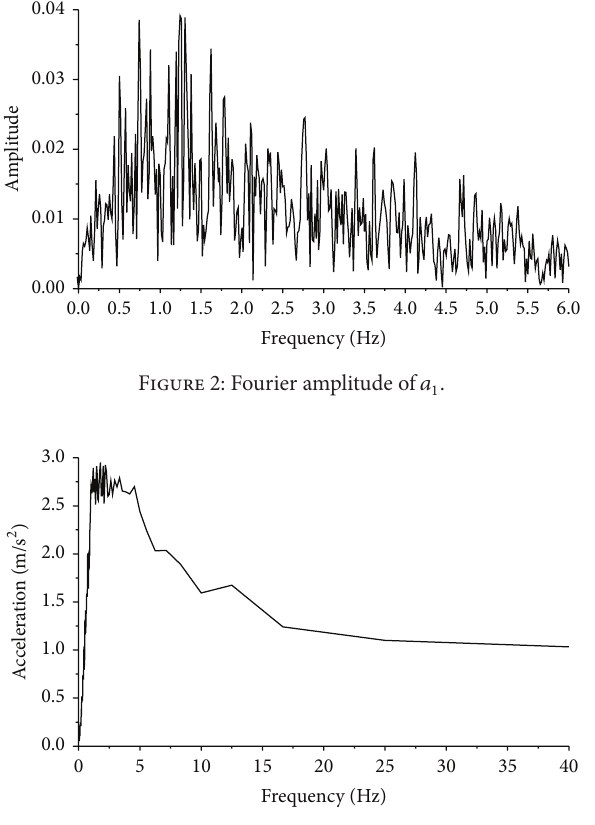
Figure 3: Acceleration response spectrum of 𝑎 1 .